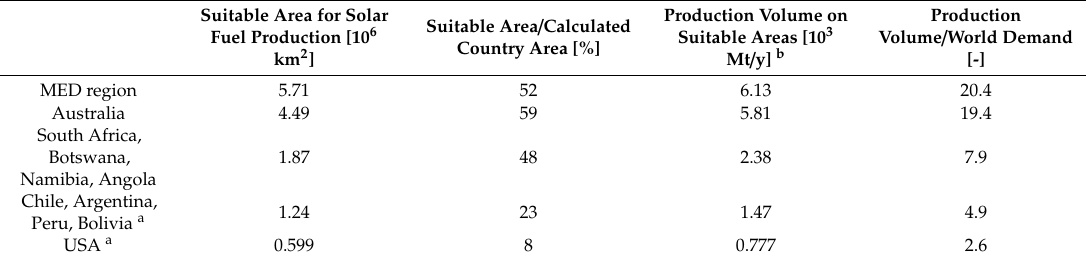
Table 2. Calculated suitable areas and production potential of solar thermochemical fuels in di ff erent